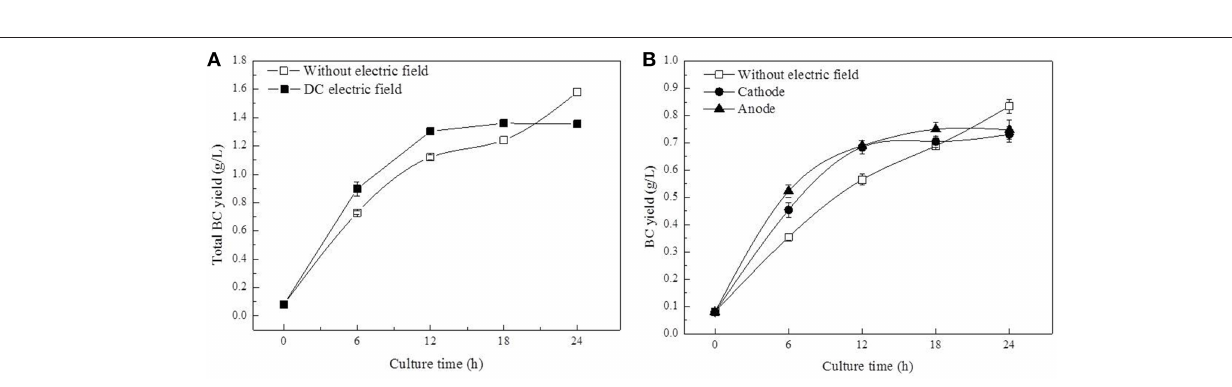
and the control cells. Samples cultured with/without DC electric field were separated clearly by PCA as shown in Figure 4A